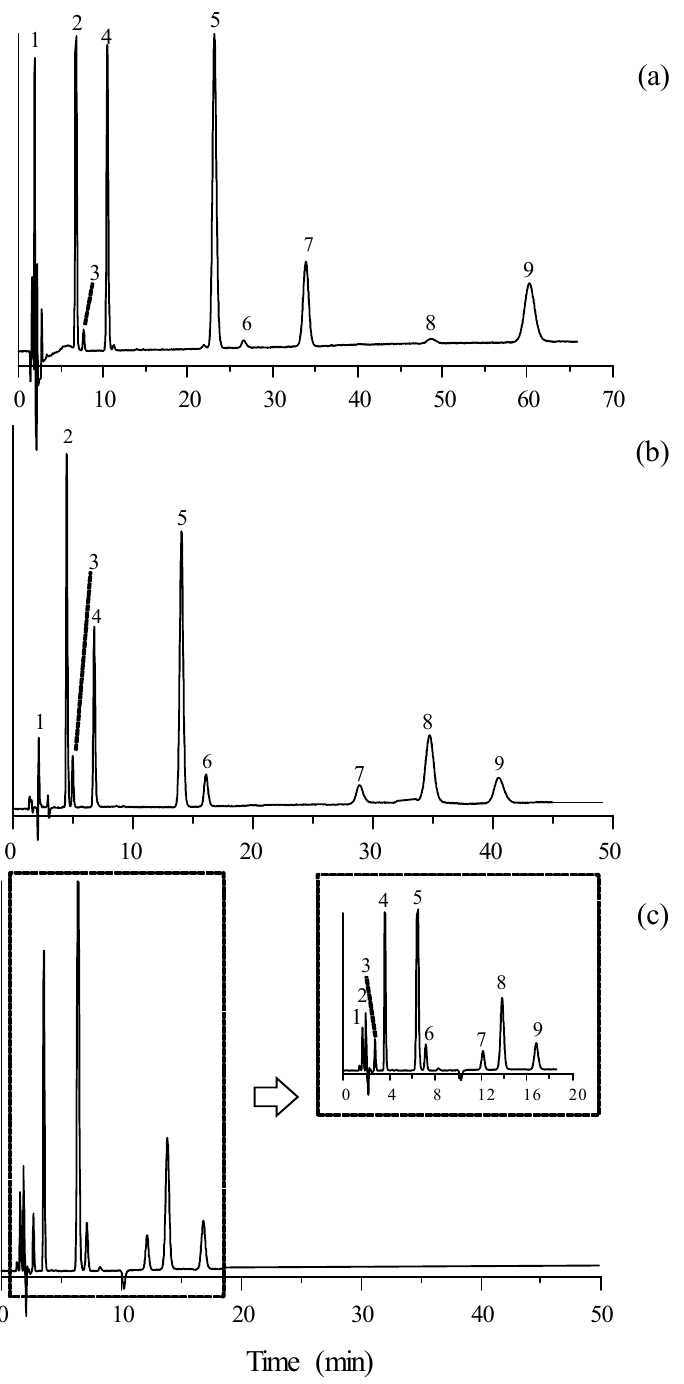
Figure 3. Chromatograms of the set of β -adrenoceptor antagonists detected at 254 nm, eluted with mobile phases containing 15% acetonitrile and 10 mM ionic liquid: ( a ) [C 2 MIM][BF 4 ], ( b ) [C 4 MIM][BF 4 ], and ( c ) [C 6 MIM][BF 4 ]. See Figure 4 for solute identity.